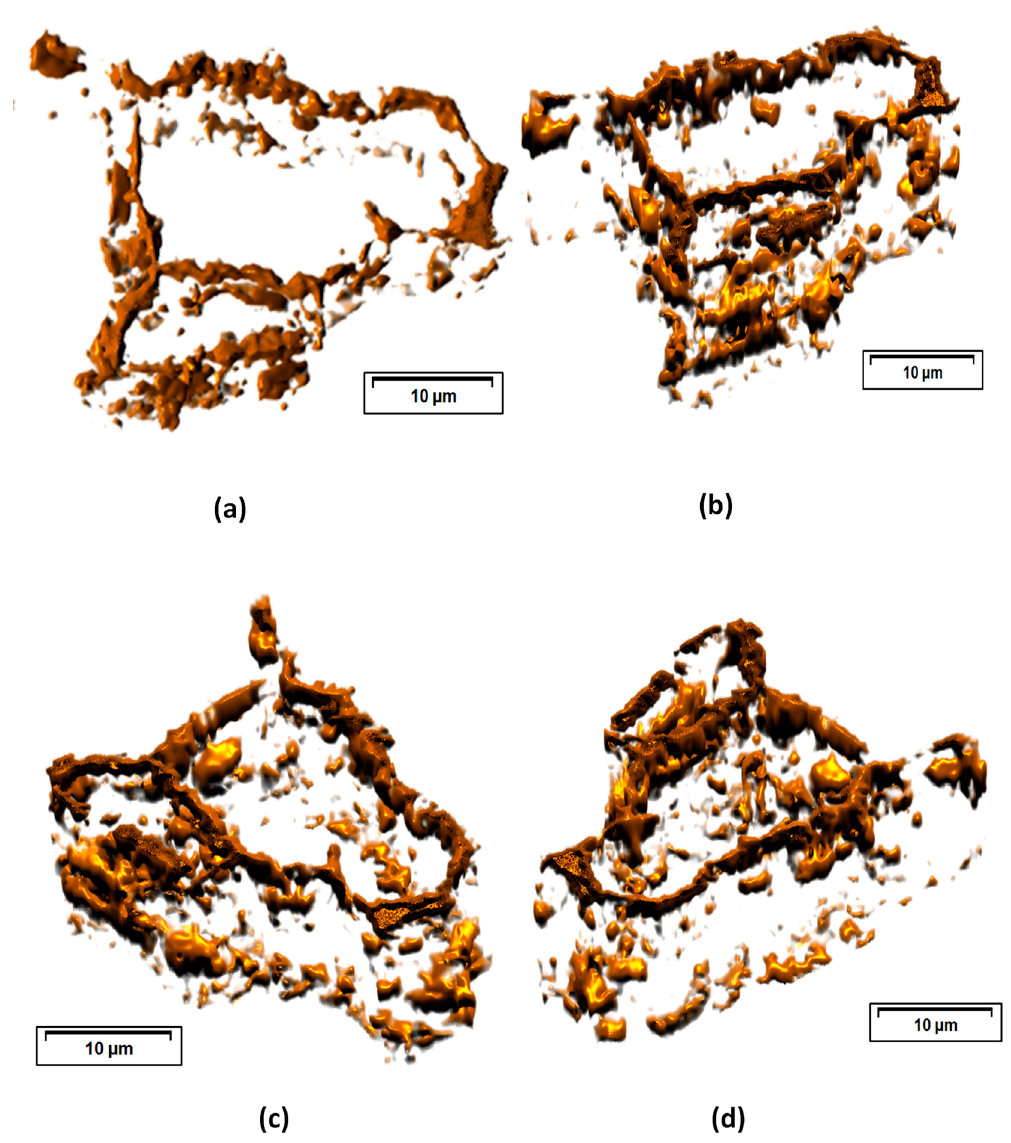
Figure 12. Sigma phase reconstructed in 3D. ( a – d ) Different viewing angles of the reconstructed region, shown in Figure 11.